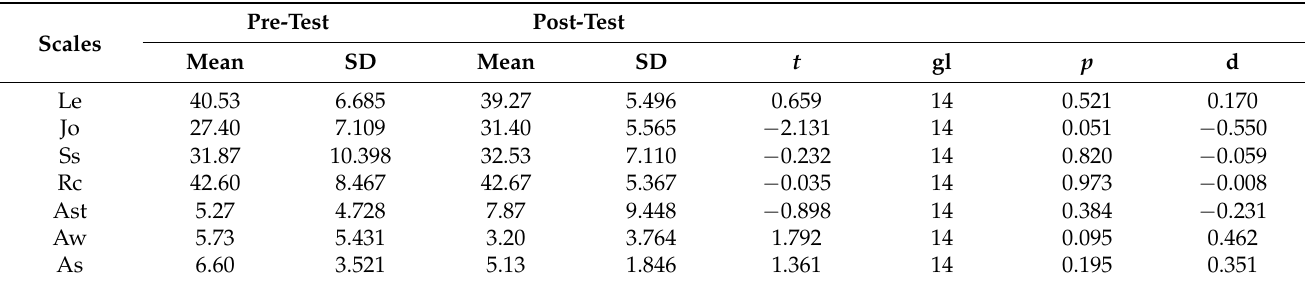
Table 9. Scores obtained in the parents’ BAS at the beginning and end of sixth grade of primary